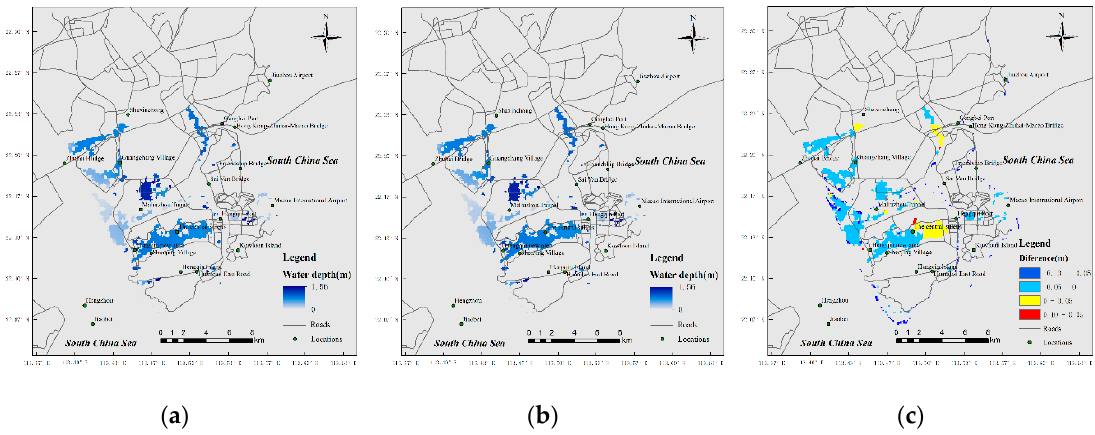
Figure 8. Inundation estimated by ( a ) MIKE 21 and ( b ) the CA simulated inundation, and ( c ) their difference (MIKE 21-CA) at 240 min.